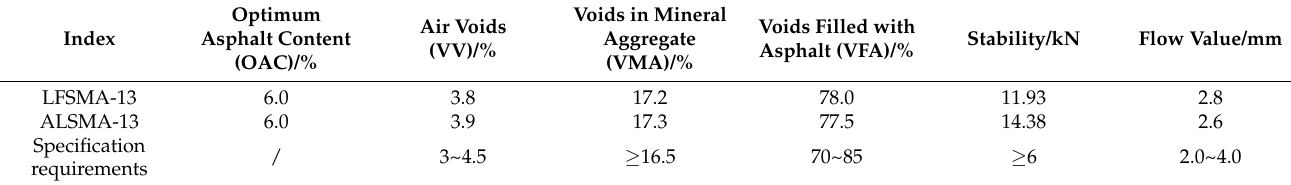
Figure 3. Gradation curve of SMA-13 asphalt mixture. Table 4. Gradation design results of SMA-13.